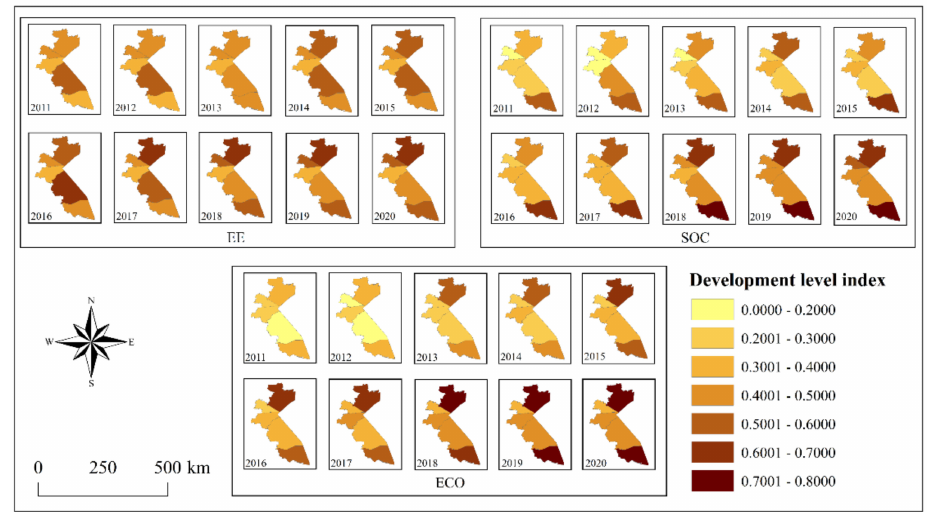
Figure 4. Coastal zone subsystem development level index changes from 2011 to